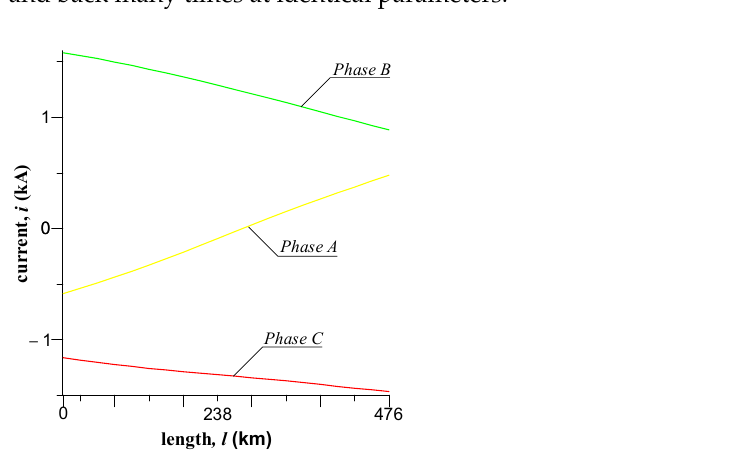
At t = 0.01 s, the voltage (Figure 6) and current (Figure 7) vs. distance are nearly linear since, by then, electromagnetic waves were running repeatedly along the line to its end and back many times at identical parameters.